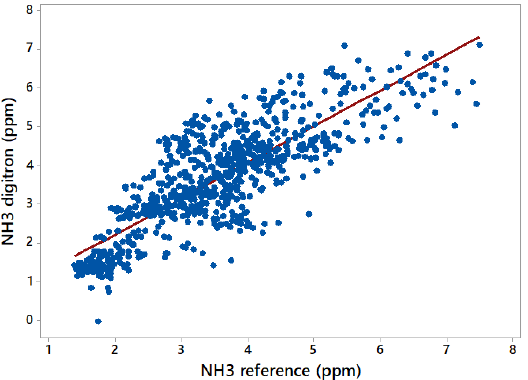
Figure 5. Linear regression analysis between NH 3 concentrations (ppm) acquired by the INNOVA analyzer (reference) and NH 3 concentrations (ppm) acquired by the low-cost device in SLA. 3.2. Analysis of the Measurement Errors The results of the ANOVA (Table 2) showed that the position of the SLs significantly influenced the relative error of the gas concentrations for both NH 3 ( p < 0.001) and CO 2 ( p < 0.001). In detail, the lowest error for the portable devices was recorded during the meas- urement of the NH 3 concentrations in SLA. There was not a significant difference between the error of gas computed in SLB and those in SLC. In these two groups, the NH 3 concen- trations were underestimated by about 60% when the measurement was carried out by the portable devices. With regard to the CO 2 measurements taken by portable devices, the results showed that the error computed at SLB was the lowest, whereas the absolute value of the error measurement for CO 2 was about 30%. In detail, the portable device underes- timated the measurements in SLA and overestimated the measurements in SLC. These results were also represented in the boxplot reported in Figure 6a,b. Moreover, it was also found that the relative error carried out by the portable devices in SLC had the highest variability for both NH 3 (Figure 6a) and CO 2 (Figure 6b). This latter finding is valuable for suggestions related to protocols applied in open dairy barns. Table 2. Results of the ANOVA ( p < 0.05) carried out for the relative error ε i (%) related to measure- ments of the gas concentrations of NH 3 and CO 2 at the three sampling locations (i.e., SLA, SLB, and SLC) by using the portable devices.